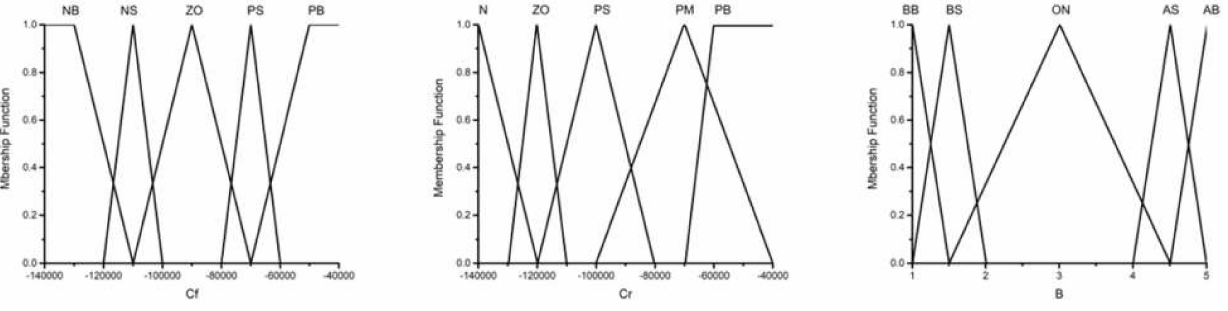
Figure 7. Membership